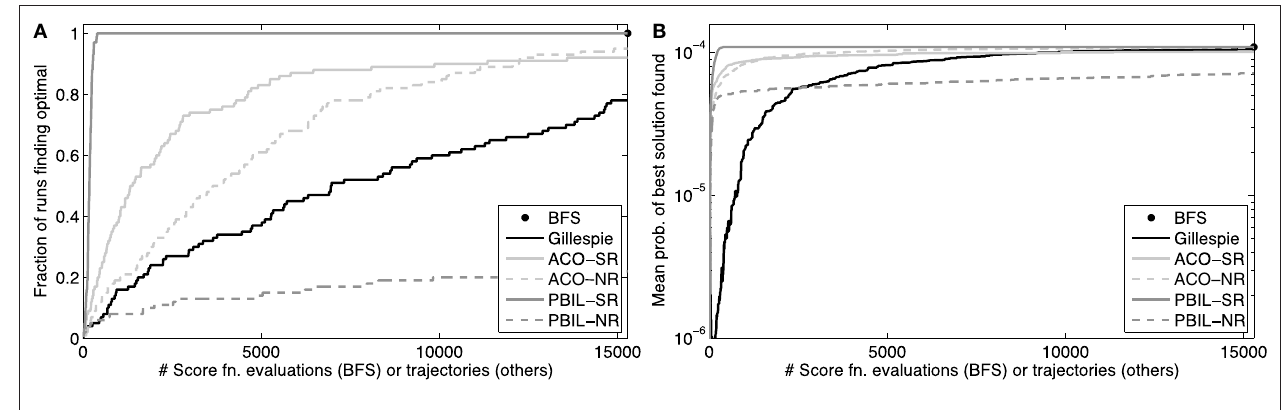
Figure 3 | Heuristic optimization results on the peptide problem with initial state 1, final state 5, and final time t = 5000 ns. “BFS” refers to best-first search, “Gillespie” to the generate-and-test approach using the Gillespie algorithm, “ACO” to ant colony optimization, and “PBIL” to population- based incremental learning. The suffix “-SR” denotes the SR matrix